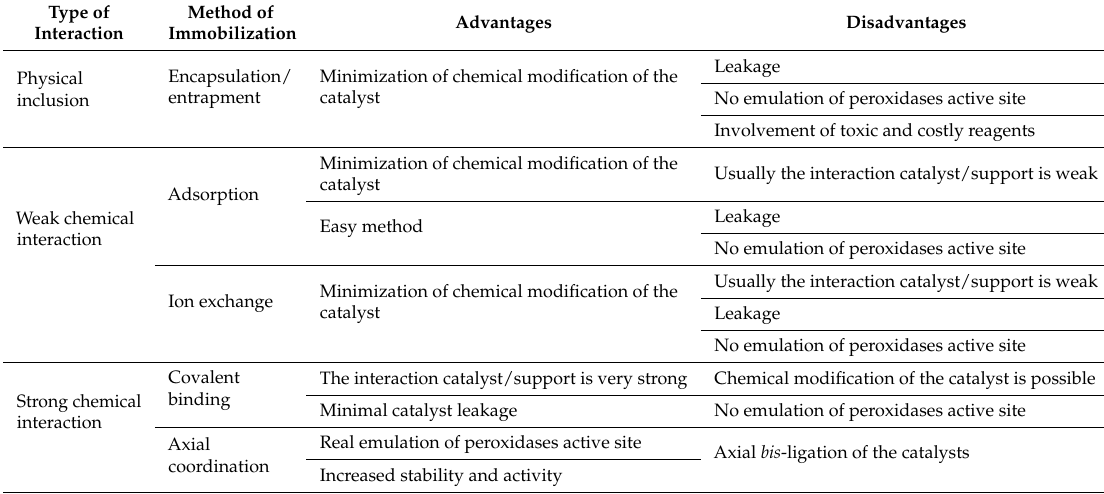
Table 3. Main features of the various immobilization approaches for metalloporphyrins